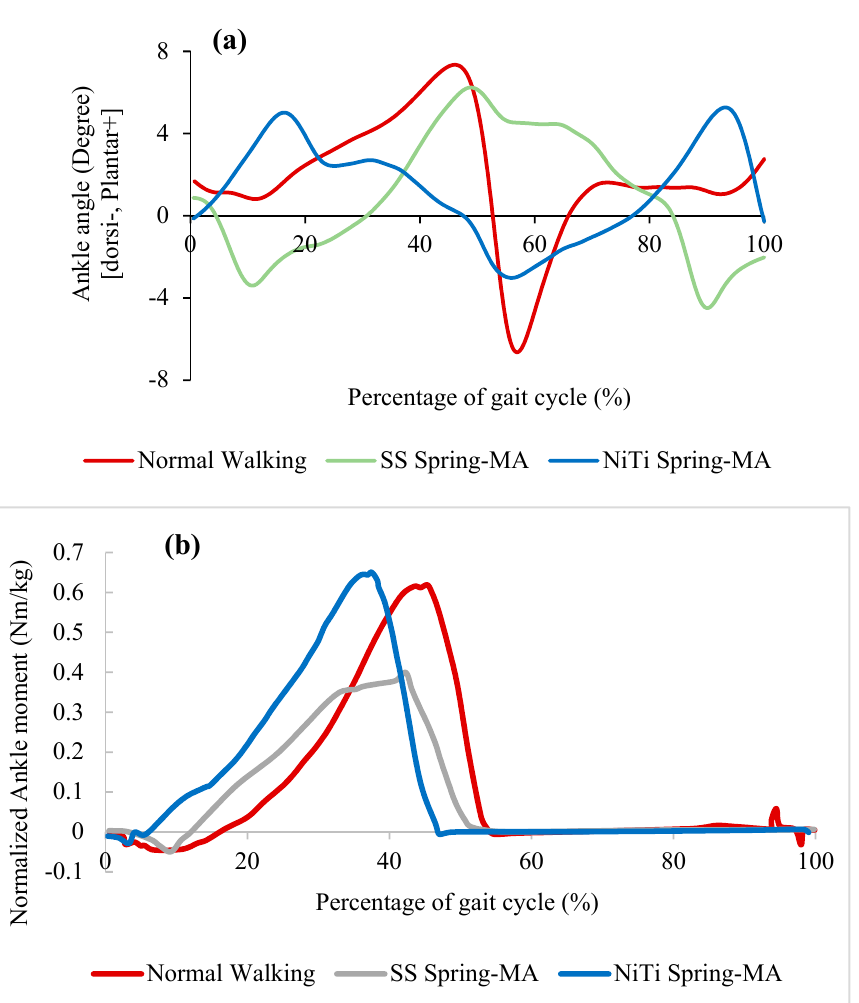
Figure 27. ( a ) Ankle angle and ( b ) normalized ankle moment over gait cycle for the healthy subject, subject wearing AFO with stainless-steel spring), and subject is wearing AFO with superelastic NiTi spring. (MA: Motion analyzed data) [54].